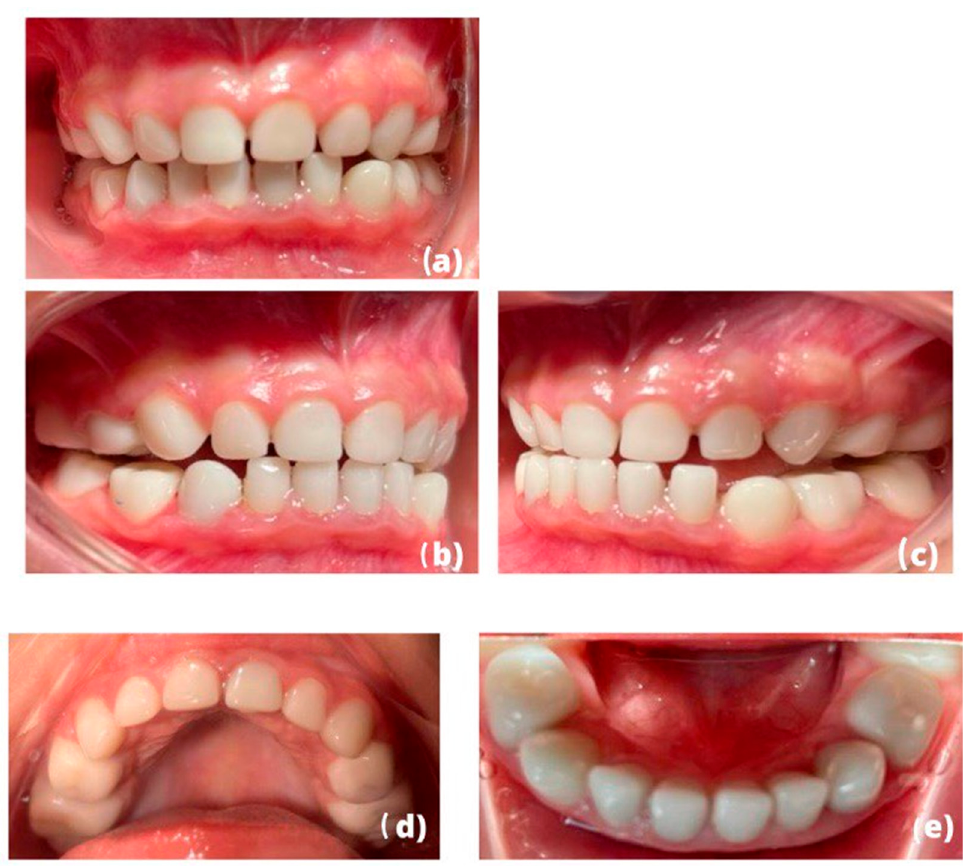
Figure 4. ( a – e ). Clinical situation at 6 months post-intervention: ( a ) in occlusion, ( b , c ) right and left side view, and ( d , e ) upper and lower maxilla.